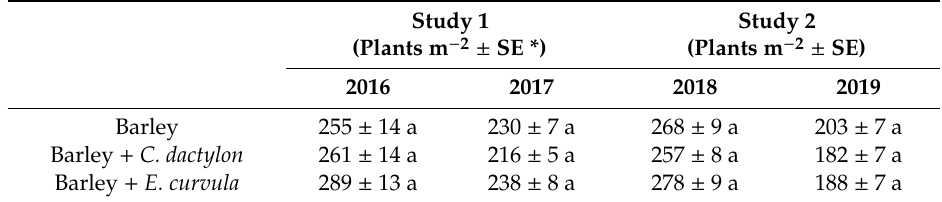
Table 2. Barley density (plants m − 2 ) in the three treatments in Studies 1 and